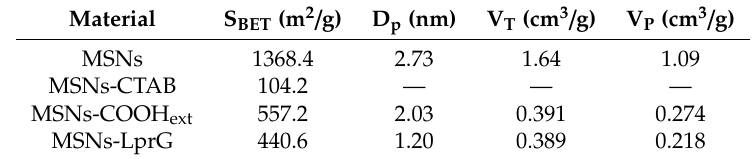
Table 4. Textural parameters of the MSN materials obtained by N 2 adsorption